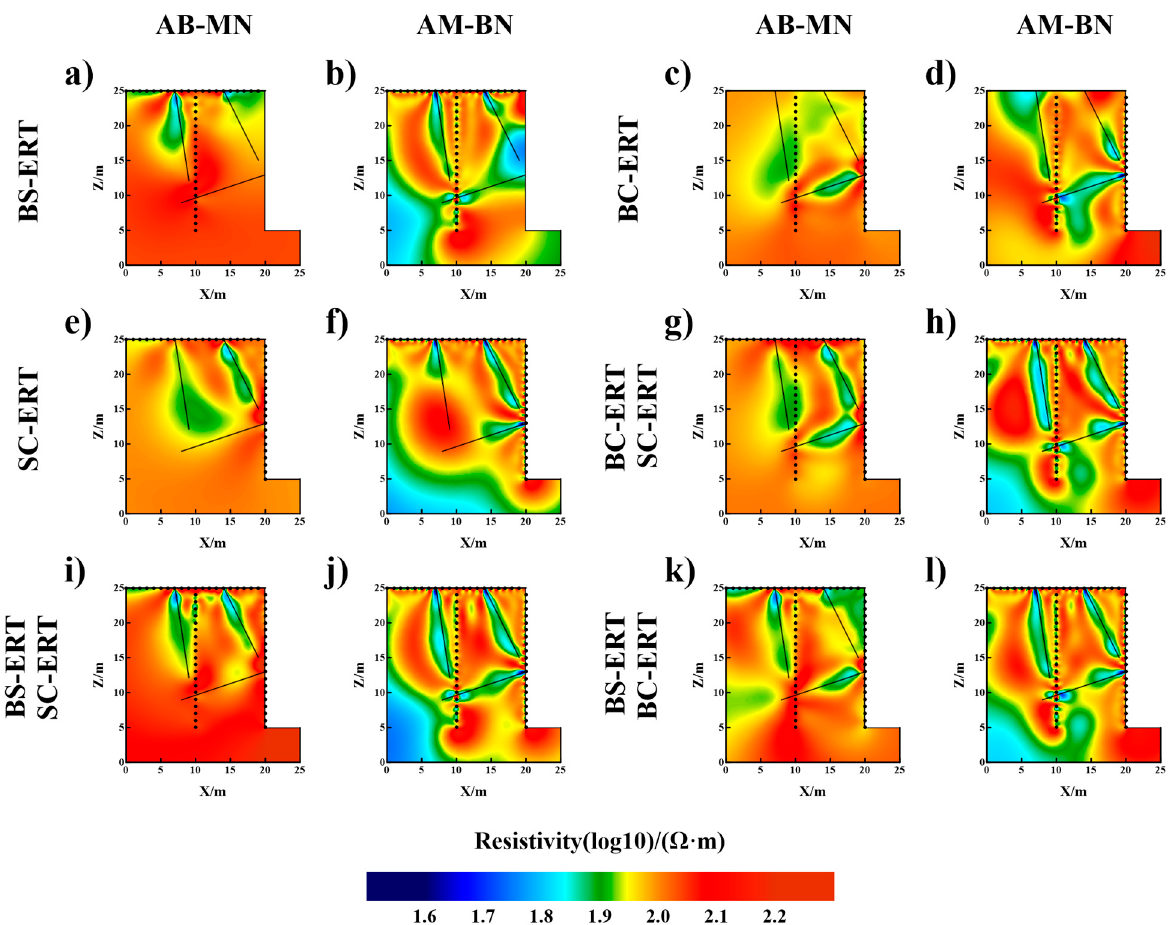
Figure 9. Resistivity images for six schemes: ( a , b ) BS-ERT scheme, ( c , d ) BC-ERT scheme, ( e , f ) SC-ERT scheme, ( g , h ) BC-ERT scheme & SC-ERT scheme, ( i , j ) BS-ERT scheme & SC-ERT scheme, ( k , l ) BS-ERT scheme & BC-ERT scheme.